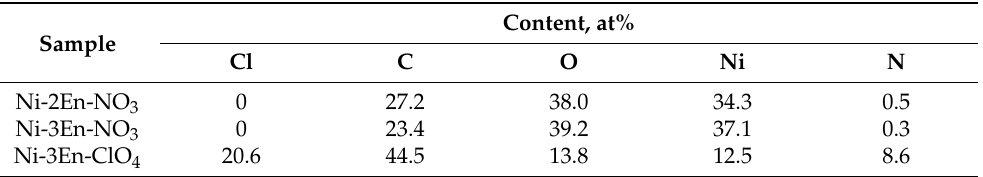
Table 5. Elemental composition of the catalyst surface for the Ni-2En-NO 3 , Ni-3En-NO 3 and Ni-3En- ClO 4 samples (XPS